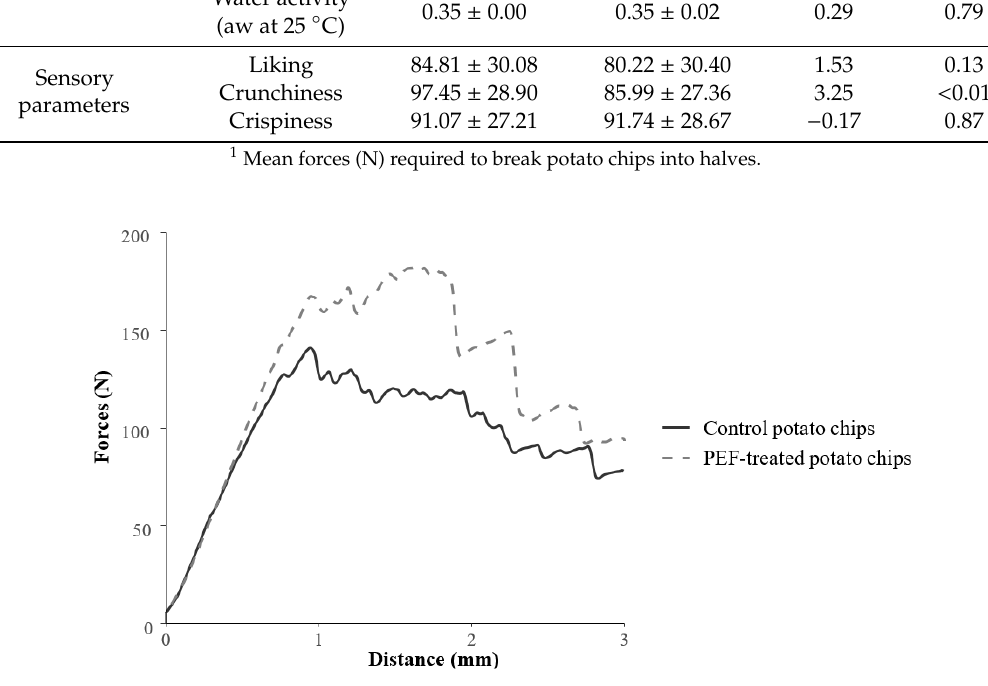
Figure 1. Plot of penetrating forces (N) against distance (mm) for the two testing potato chips measured by the textural analyser.